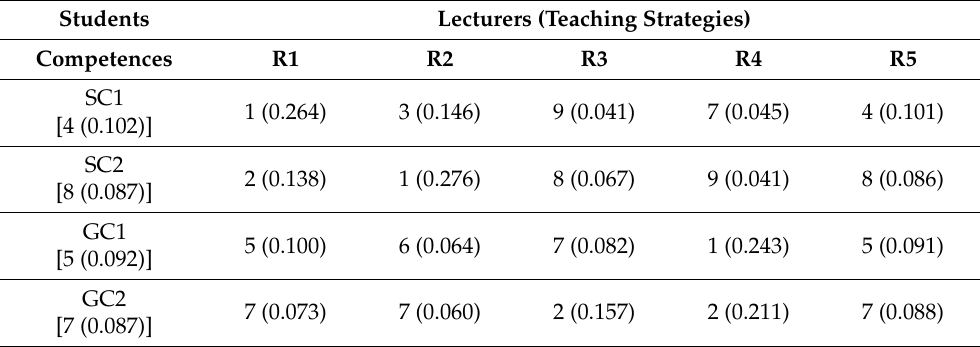
Table 5. Result of the votes for the teaching strategies. The figures in brackets show the normalized weight of each teaching